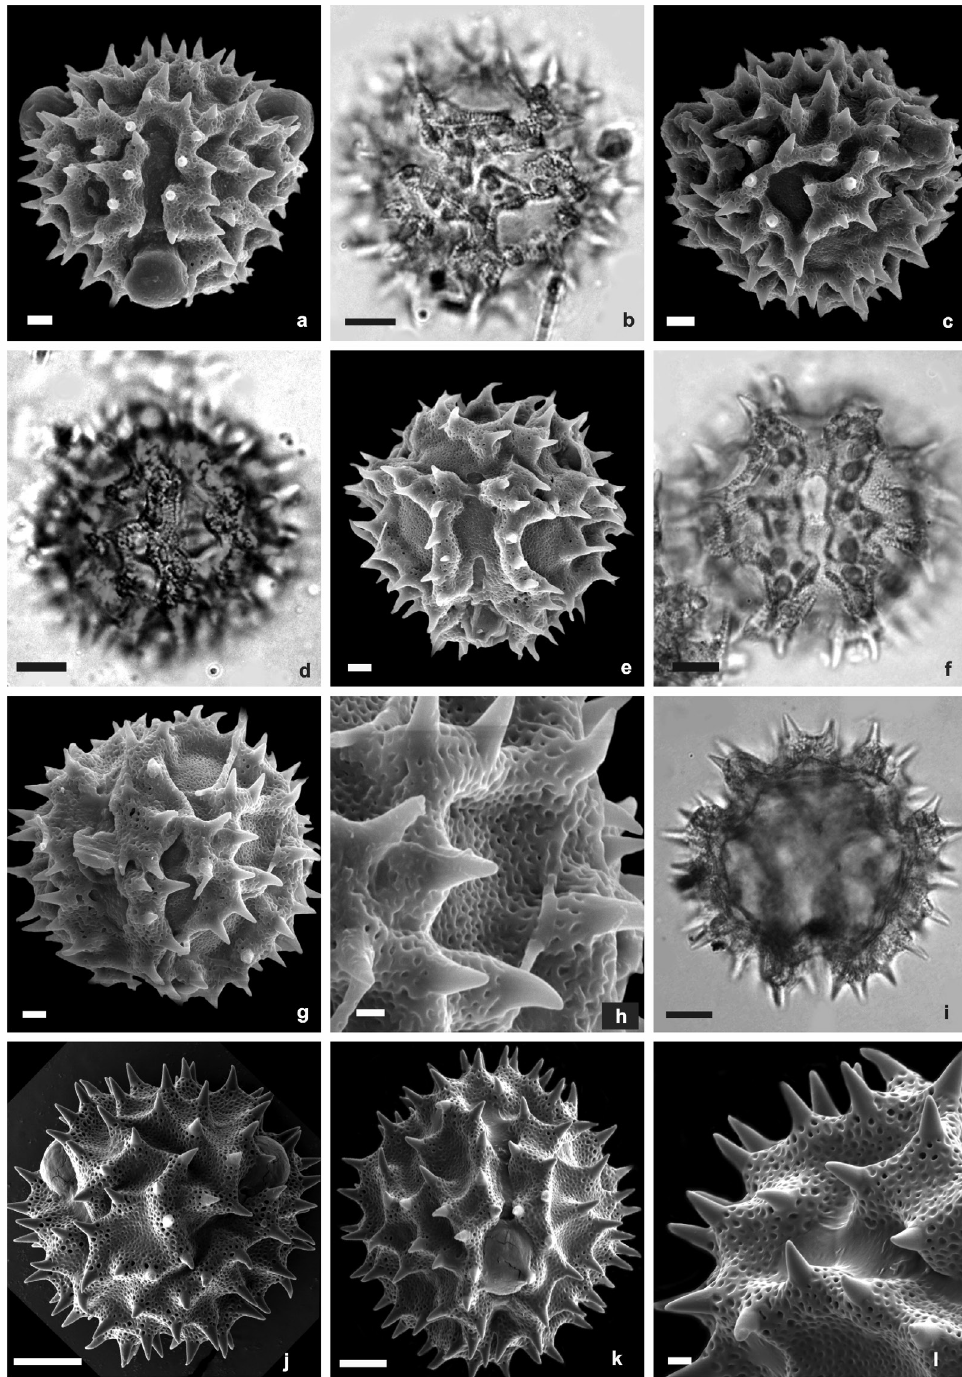
Figure 2. Light microscopy (LM) and scanning electron microscopy (SEM) images of pollen grains of Piptolepis species. P. gardneri - a. polar view, general aspect (SEM), b. surface (ML), c. mesocolporus (SEM). d. equatorial view, general aspect and aperture (ML). P. glaziouana - e. polar view, general aspect (SEM), f. equatorial view, general aspect and aperture (ML), g. mesocolporus (SEM), h. surface detail (SEM). P. imbricata - i. polar view, optical section (ML), j. general aspect, mesocolporus (SEM), k. equatorial view, aperture (SEM), l. surface detail (SEM). Scale bar: 5 µm (a, c, e, g), 10 µm (b, d, f, i, j, k), 1 µm (h,